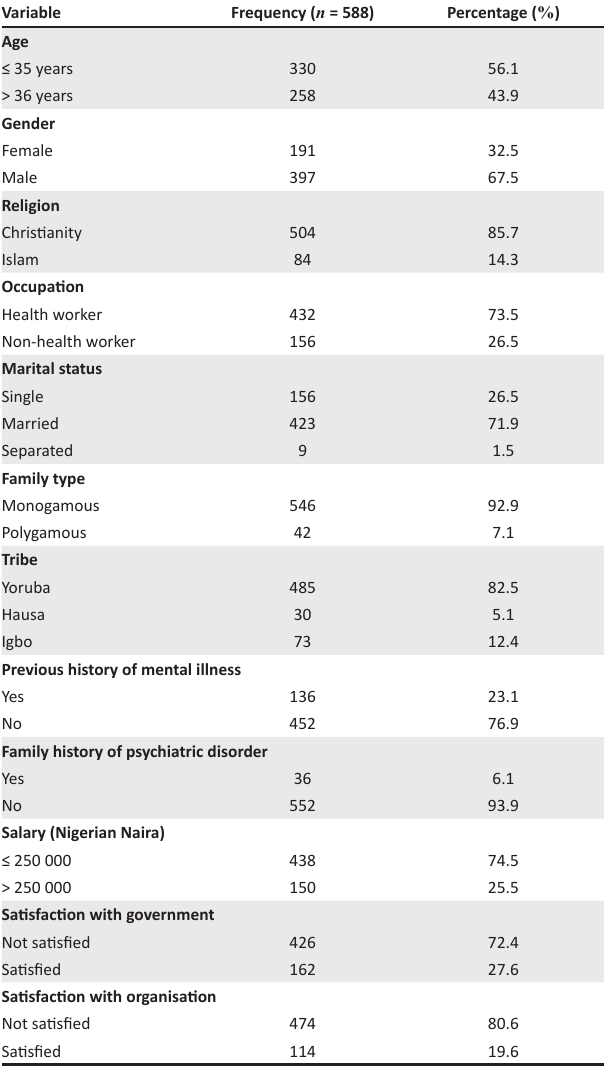
TABLE 1: Socio-demographic characteristics of the respondents.